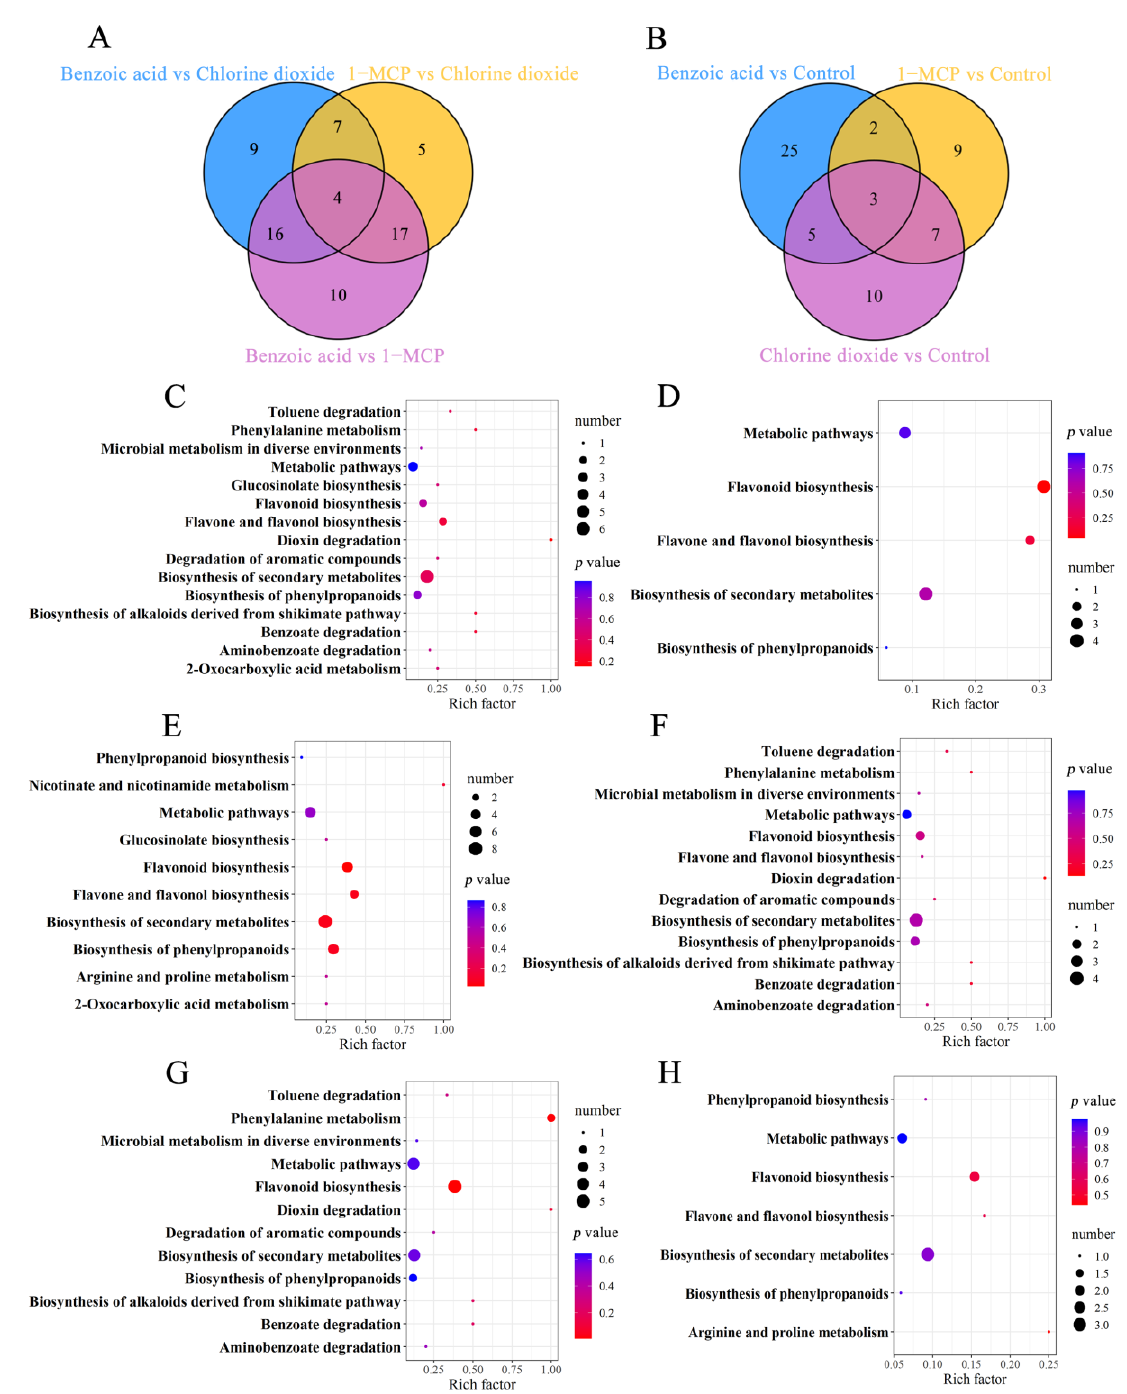
Figure 4. Venn diagram revealing DAMs numbers from different combinations ( A , B ). KEGG pathway enrichment analysis of DAMs in different combinations of Benzoic acid vs. Chlorine dioxide ( C ), Benzoic acid vs. 1-MCP ( D ), Benzoic acid vs. Control ( E ), Chlorine dioxide vs. Control ( F ), 1-MCP vs. Chlorine dioxide ( G ), 1-MCP vs. Control ( H ). The x -axis and y -axis represent the enrichment factor and the enrichment pathway, respectively. Low and high p values are expressed by the red circle and the blue circle, respectively. The area of a circle is the DAM number. The enrichment was performed by Fisher’s exact test.